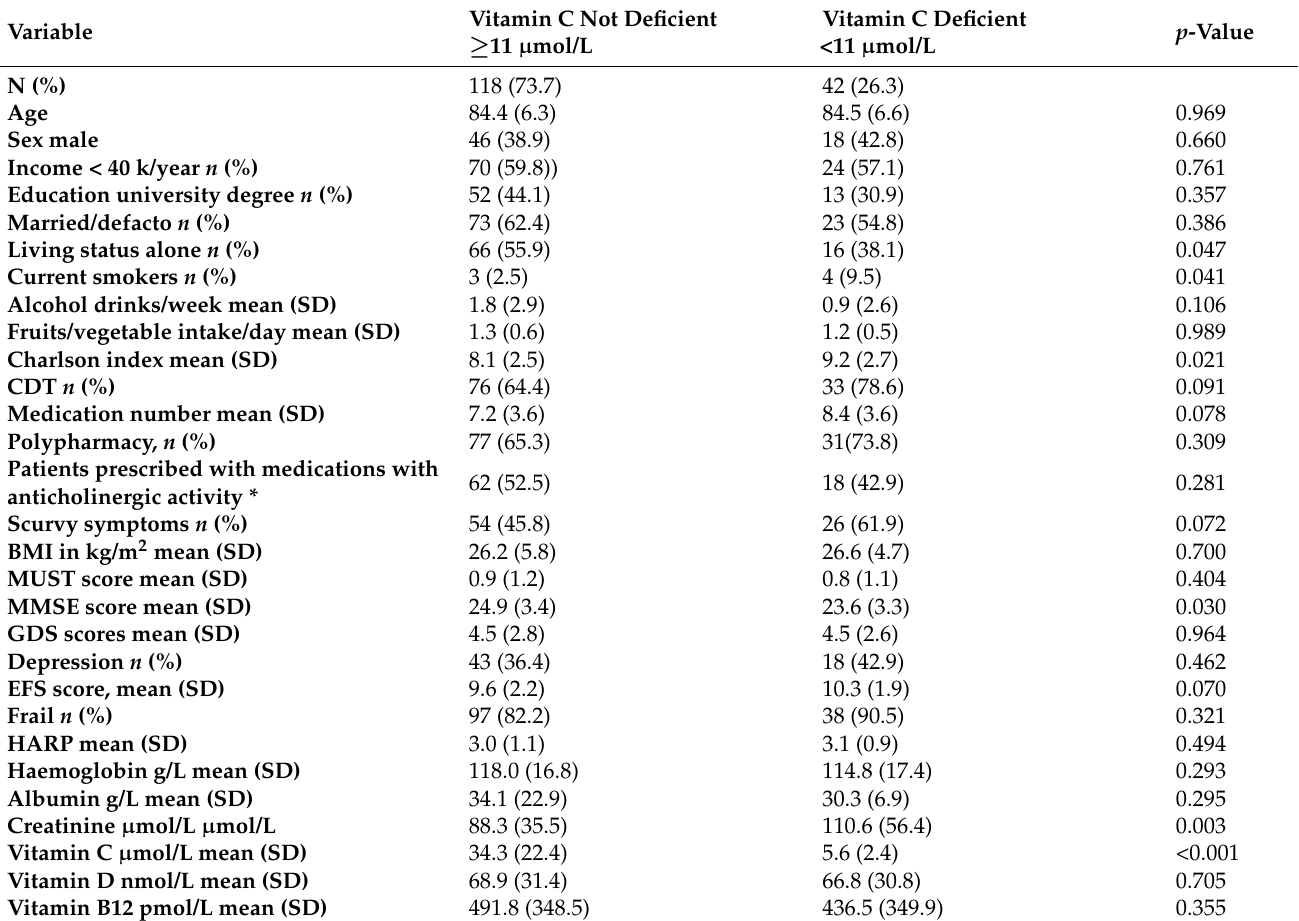
Table 1. Characteristics of patients with and without vitamin C deficiency.